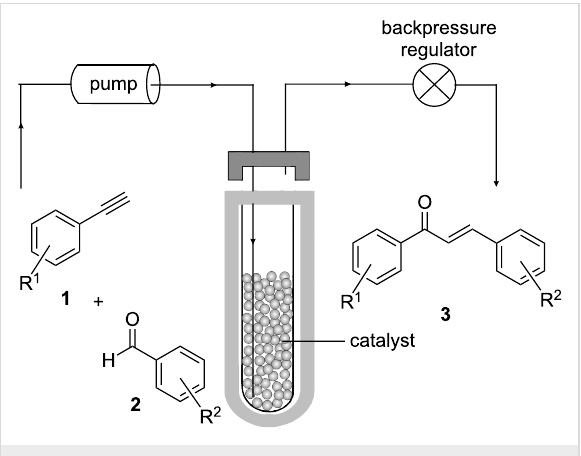
Scheme 1: The schematic arrangement of the continuous-flow